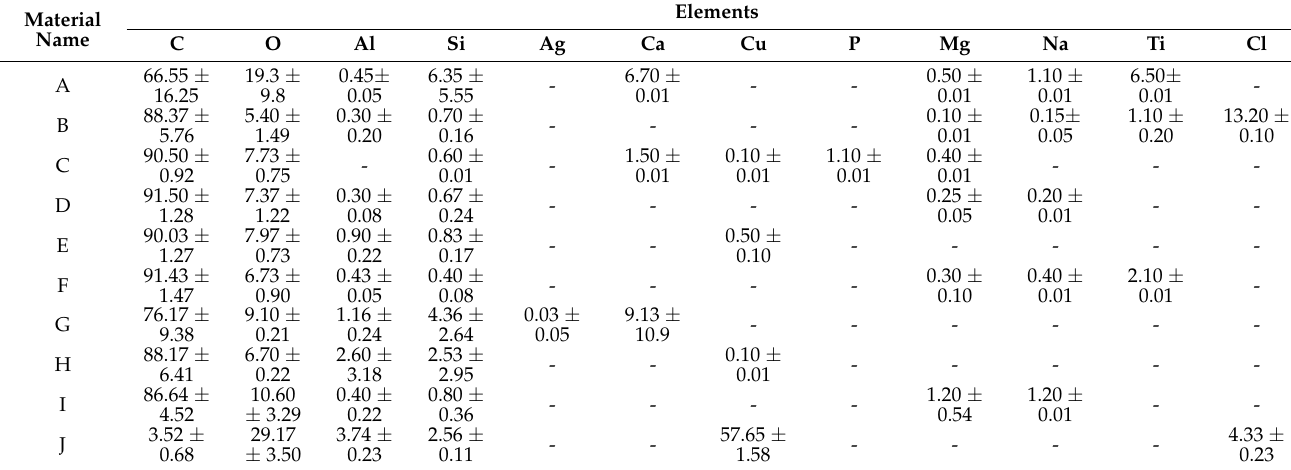
Table 4. Results of SEM–EDS analysis—the presence of specific elements in analyzed micro-areas of filaments. Material